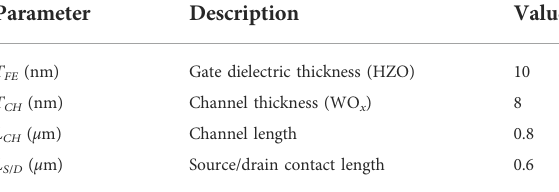
TABLE 3 Geometrical parameters of the double-gate FeFET transistor in Figure 8. Parameter